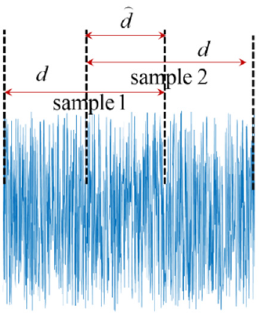
Figure 4. Illustration of time series sliding window with overlapping.